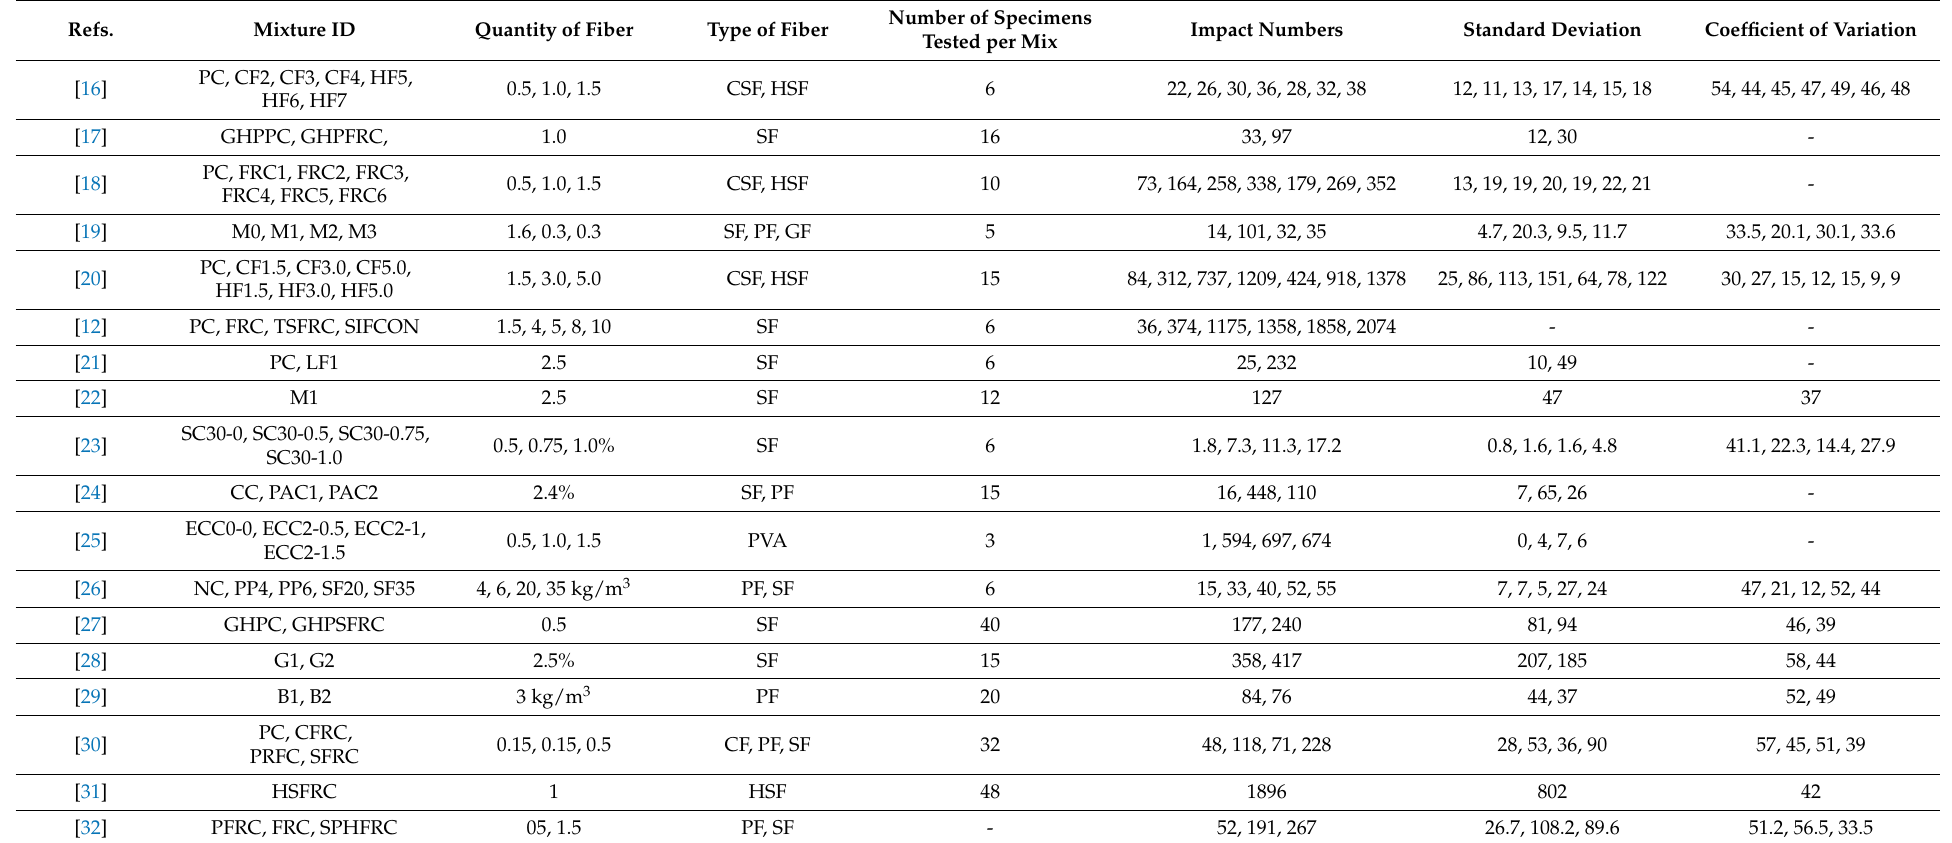
Table 1. Summary of drop weight impact test results reported by earlier